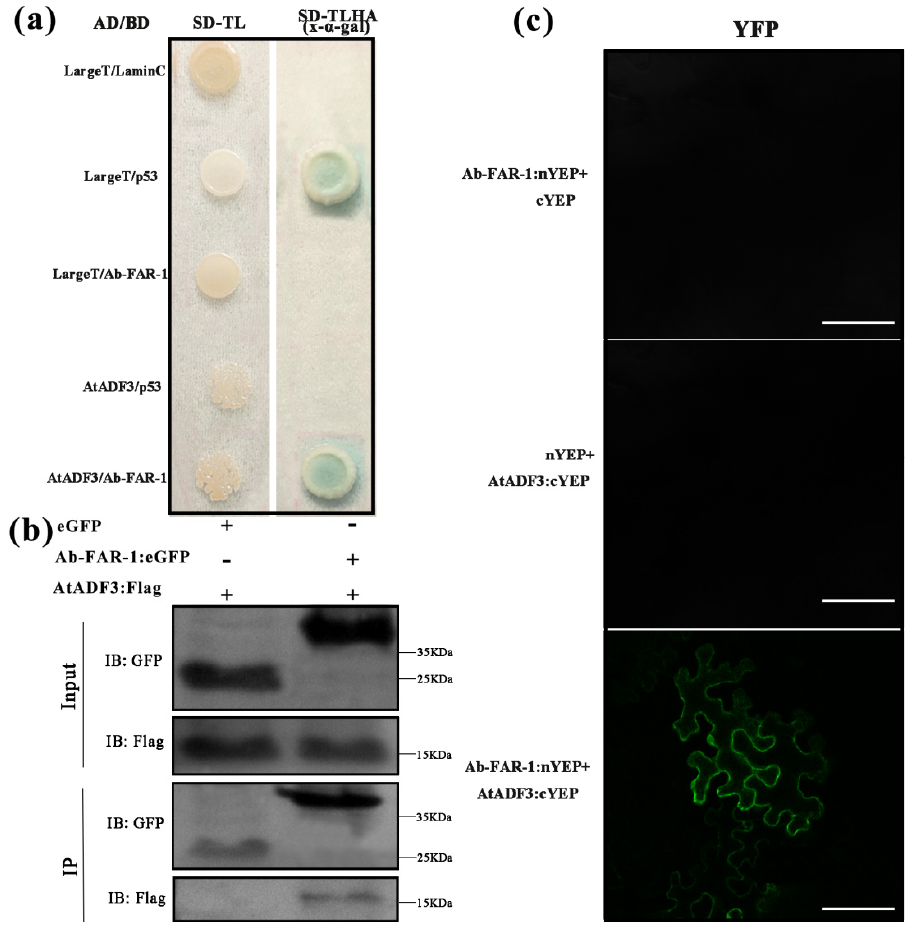
Figure 6. Ab-FAR-1 Δ sp interacts with AtADF3. ( a ) The yeast two-hybrid interaction between Ab-FAR-1 Δ sp and AtADF3. Left column, cotransformants grown on SD-TL (-trp -leu) agar medium demonstrate that both bait and prey plasmids are present in yeast ( Saccharomyces cerevisiae ); right column, only yeast cells containing the Ab-FAR-1 Δ sp bait plus the AtADF3 prey or the positive control interaction of LargeT plus p53 grew and turned blue on the selective medium SD-TLHA (-trp –leu –his -ade) + x- α -gal agar medium. Ab-FAR-1 Δ sp , p53 and LaminC were cloned into the pGBKT7 vector, while AtADF3 and LargeT were cloned into the pGADT7 vector, respectively. LargeT was cotransformed with p53 as a positive control. LargeT/LaminC, AtADF3/LaminC and LargeT/Ab-FAR-1 Δ sp cotransformations were negative controls. ( b ) Co-immunoprecipitation of AtADF3 with Ab-FAR-1 Δ sp . Ab-FAR-1 Δ sp :eGFP or eGFP was transiently co-expressed with AtADF3:Flag in tobacco leaf cells. The isolated protein was analysed by immunoblotting with anti-Flag antibodies to detect AtADF3 and anti-GFP antibodies to detect Ab-FAR-1 Δ sp . ( c ) Bimolecular fluorescent complementation (BiFC) visualization of the Ab-FAR-1 Δ sp with AtADF3 interaction. Ab-FAR-1 Δ sp : nYFP and AtADF: cYFP were co-expressed in tobacco leaves. Controls were performed by co-expressing nYFP and AtADF3:cYFP, Ab-FAR-1 Δ sp :nYFP and cYFP. Bars = 100 μ m as shown. Three independent experiments were performed with similar results.